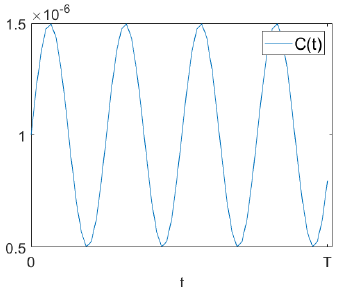
Figure 12. Example waveforms of parametric capacitance C ( t ) in farads for N = 600. The calculated current as well as one resulting from simulation in Matlab is shown in Figure 13.